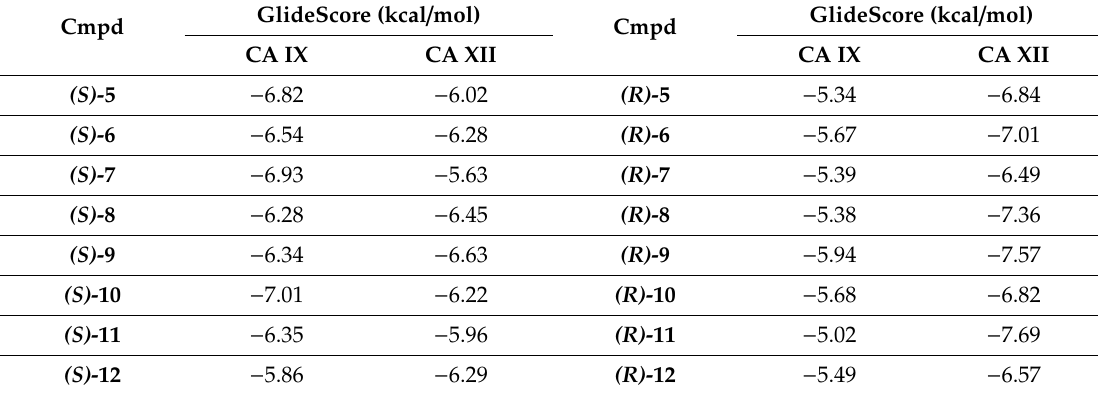
Table 2. Docking score (Glide) of the predicted poses of (R) - and (S) -enantiomers of 5–25 and